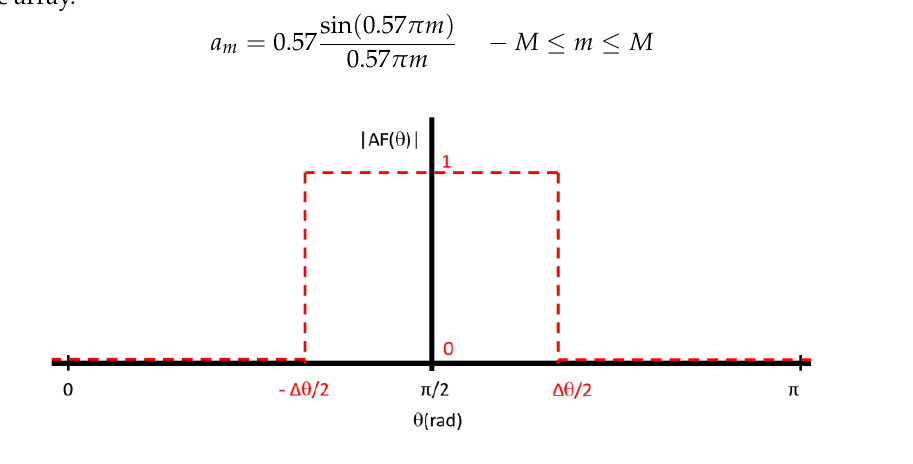
Figure 5. Desired array factor.